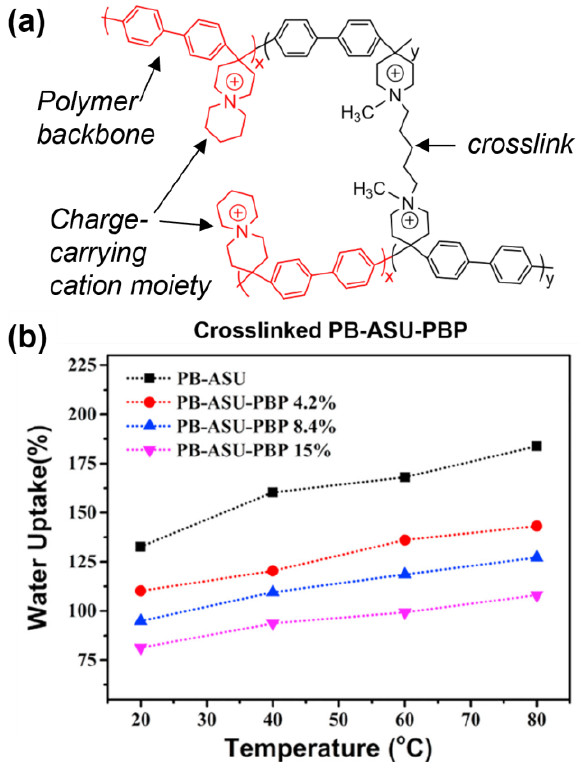
Figure 3. ( a ) Chemical structure of the controllable crosslinking of poly(arylene 6-azaspiro[5.5] undecanium). ( b ) Percent WU as a function of temperature. Adapted with permission from Ref. [81]. Copyright 2019 Elsevier.